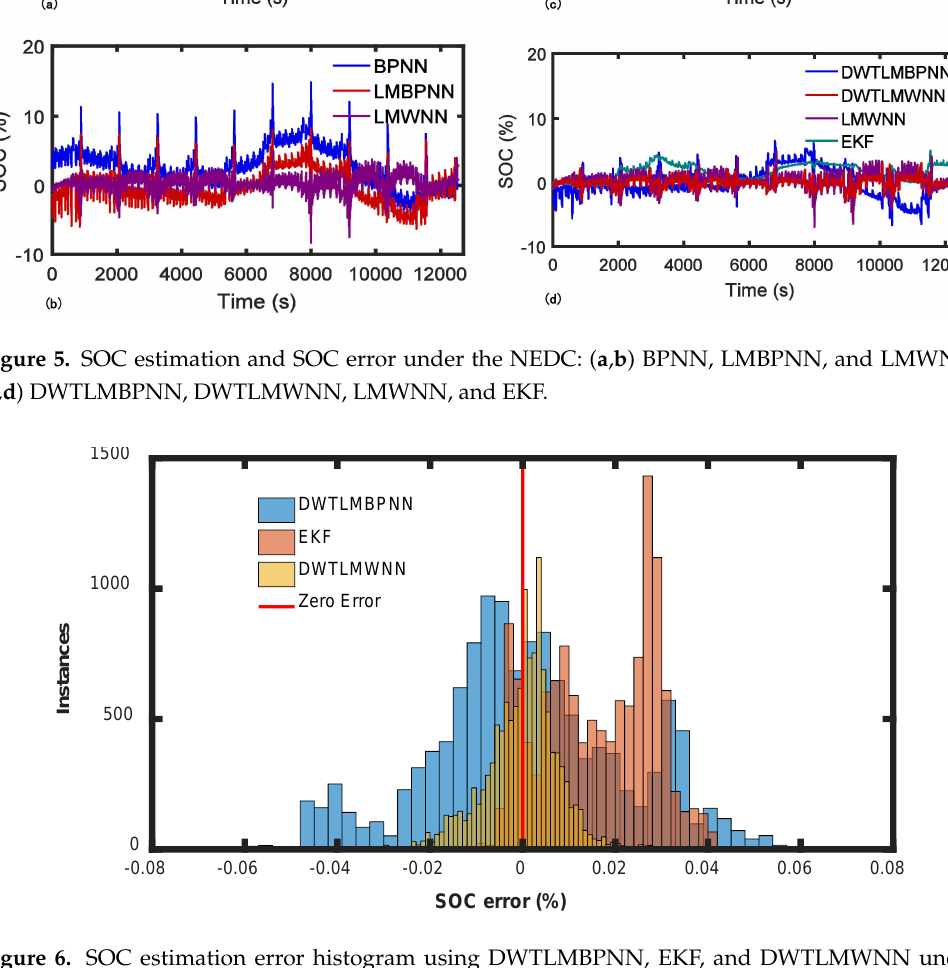
Figure 6. SOC estimation error histogram using DWTLMBPNN, EKF, and DWTLMWNN under the NEDC. Table 1. Mean and maximum SOC error of BPNN, LMBPNN, LMWNN, DWTLMBPNN, DWTLMWNN, and